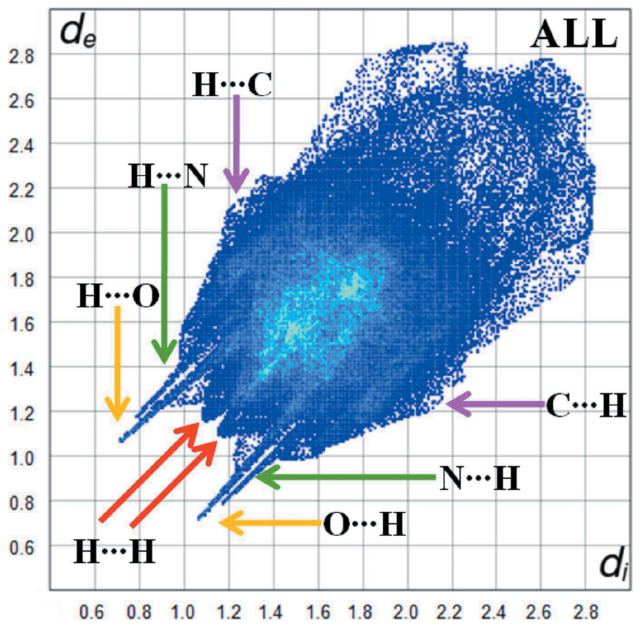
Figure 7 Two-dimensional fingerprint plot for the sum of the contacts contributing to the Hirshfeld surface.